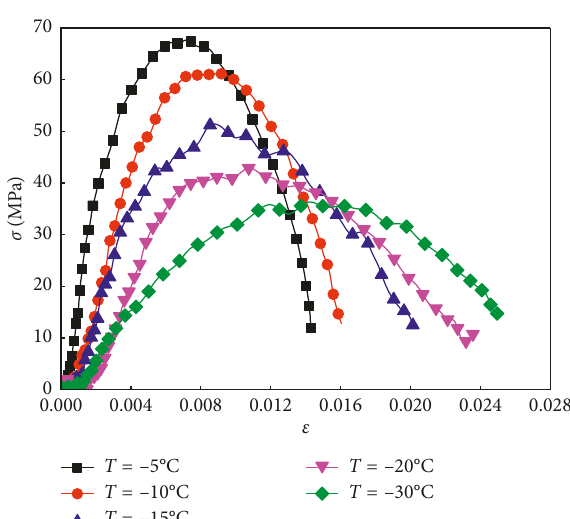
Figure 6: Stress-strain curves of yellow sandstone at different